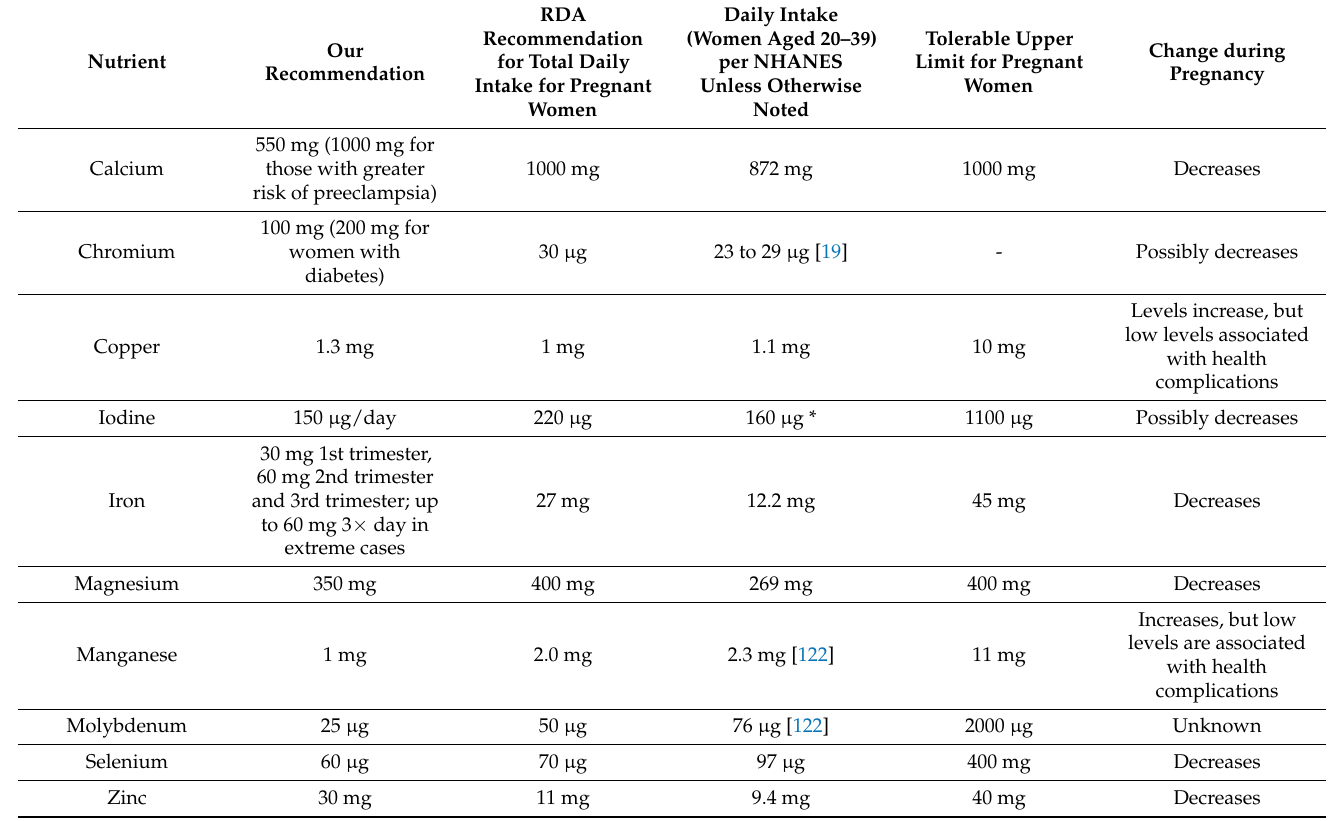
Table 5. Recommendations for content of prenatal supplements and other relevant data for comparison.